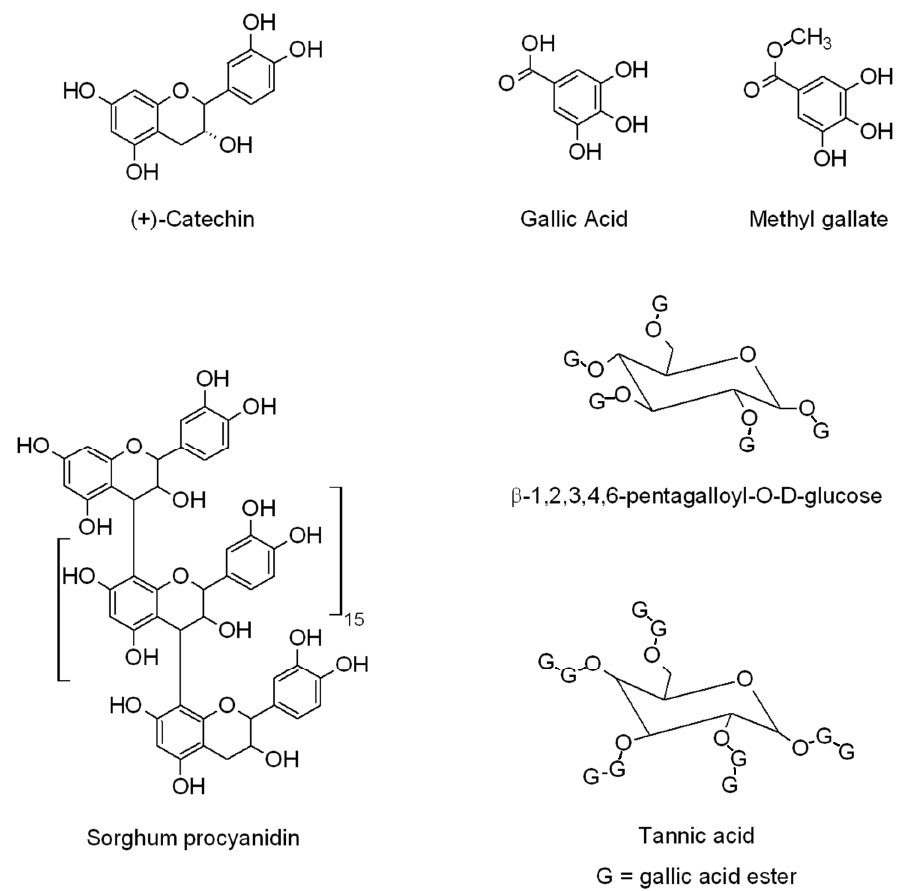
Figure 1. Chemical structures for (+)-catechin (CAT), gallic acid (GA), methyl gallate (MG), penta-galloyl-glucose (PGG), sorghum proanthocyanidin (SOR), and tannic acid (TA). The structure shown for tannic acid is a representative molecule for tannic acid, an imprecisely defined mixture of hydrolysable